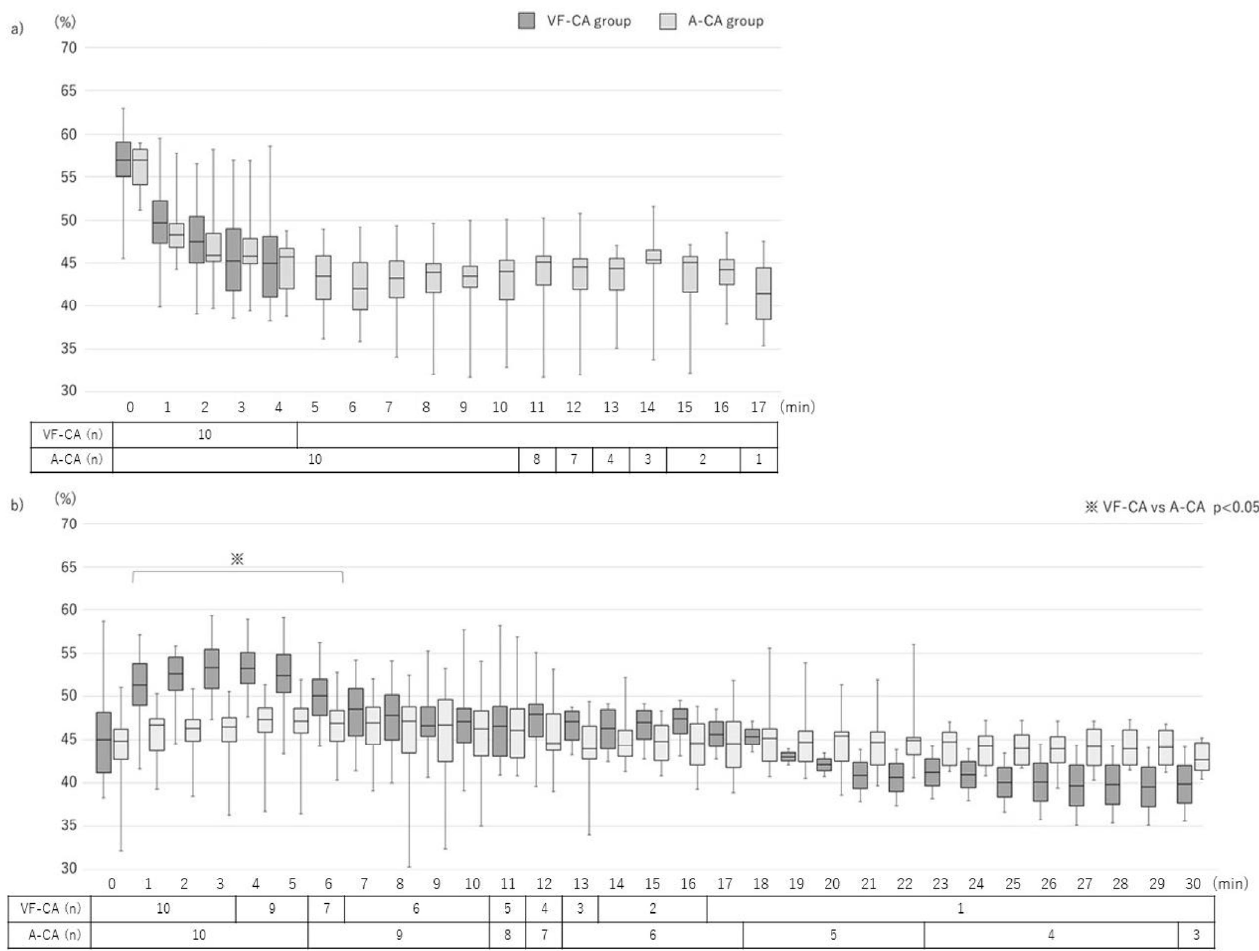
Figure 3. Changes in cerebral oxygen saturation (tissue oxygenation index; TOI) in the pre-CPR and CPR phases. ( a ) Pre-CPR phase: 4 min elapsed from VF induction to CPR initiation in the VF-CA group; 13.9 (12.5–15.3) min elapsed from clamping to CPR initiation in the A-CA group. The TOI increased comparably in both groups ( p = 0.188). ( b ) CPR phase: the TOI values increased di ff erently